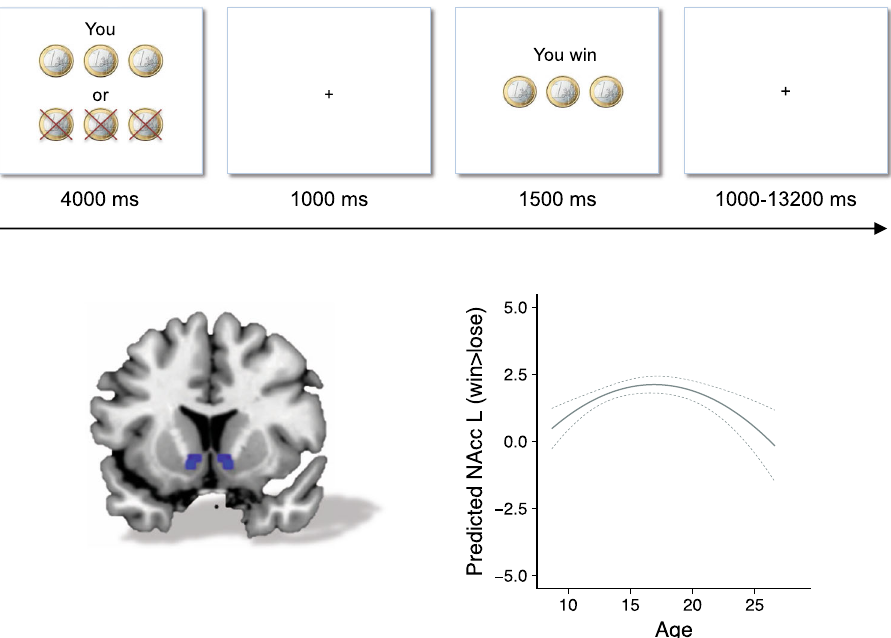
Fig. 3 Longitudinal neural developmental pattern of reward activity in adolescence. Longitudinal two-wave neural developmental pattern of nucleus accumbens activation during winning vs. losing, based on 249, and 238 participants who were included on the fi rst and second time point, respectively (leading to 487 included brain scans in total). A quadratic pattern of brain activity was observed in the nucleus accumbens for the contrast winning > losing money in a gambling task, with highest reward activity in mid-adolescence. (Adapted with permission from Braams et al. 55 )